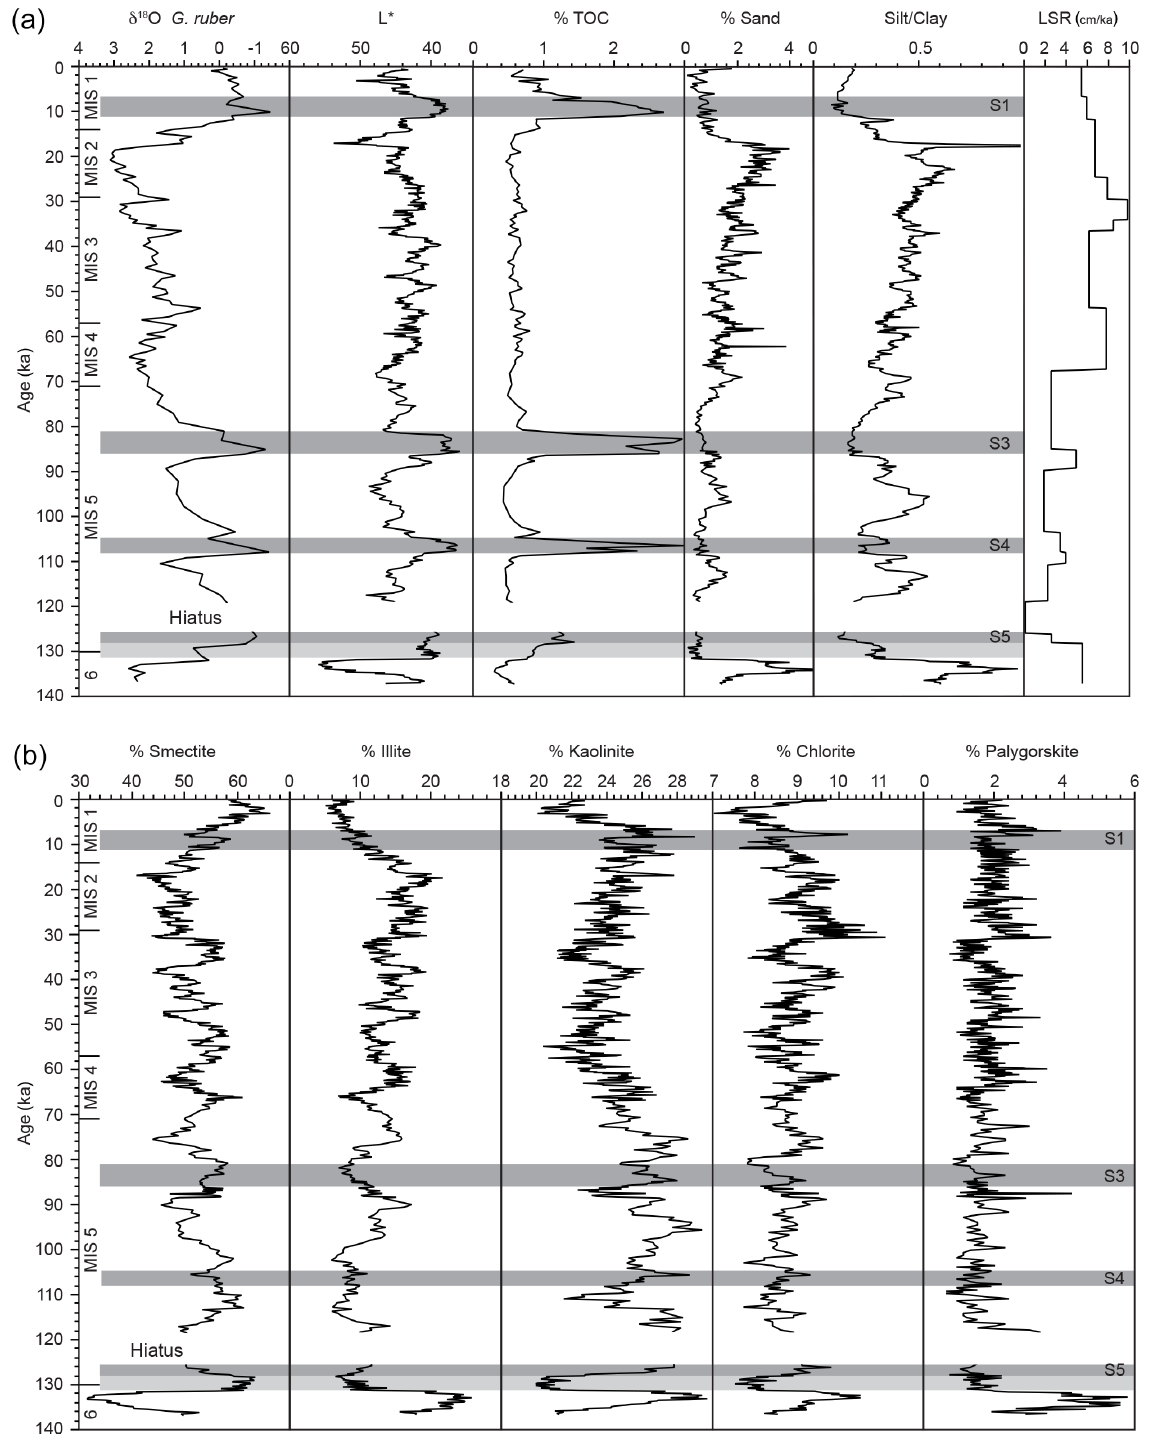
Figure 3. Basic data of core GeoTü SL110. Panel (a) : δ 18 O of G. ruber , lightness ( L ∗ ), % total organic carbon (TOC), and % sand and silt / clay ratio of the terrigenous sediment fraction, and linear sedimentation rates (LSRs; cmka − 1 ). Panel (b) : clay mineral percentages of smectite, illite, kaolinite, chlorite, and palygorskite. Grey bars mark the position of sapropel layers S1, S3, S4, S5, and the pre-sapropelic layer beneath S5 (light grey). Marine isotope stages (MISs) are